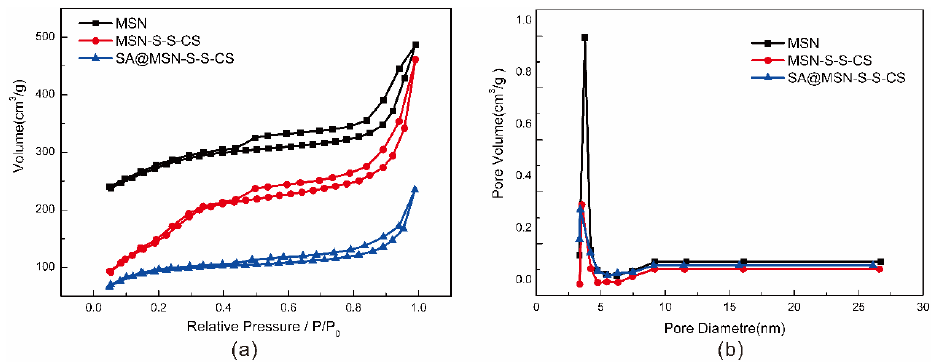
Figure 2. SEM images of mesoporous silica nanoparticles (MSN).